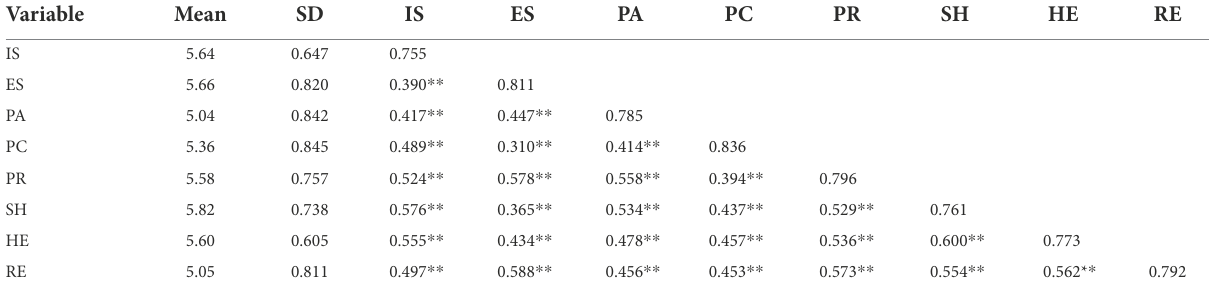
Diagonal values represent square root values of the AVE. ** p < 0.01. TABLE 5 Results of path